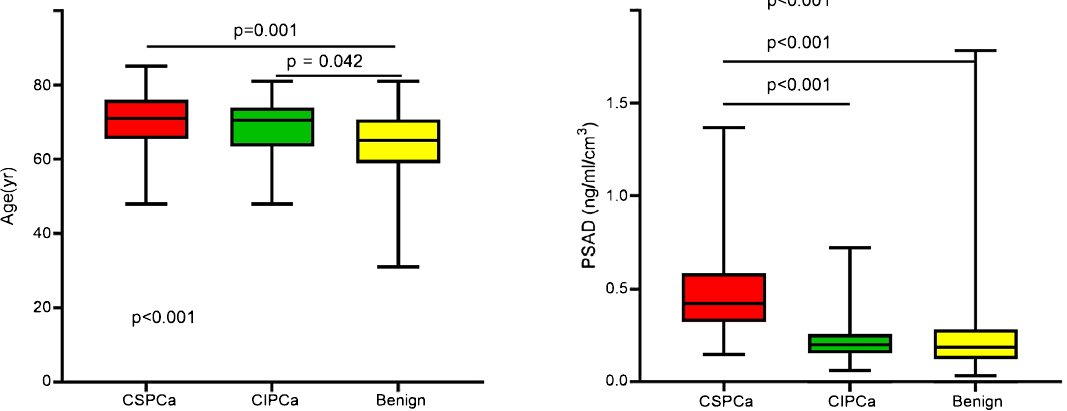
Figure 2. Age and PSAD by PBx histology in patients with negative MRI.